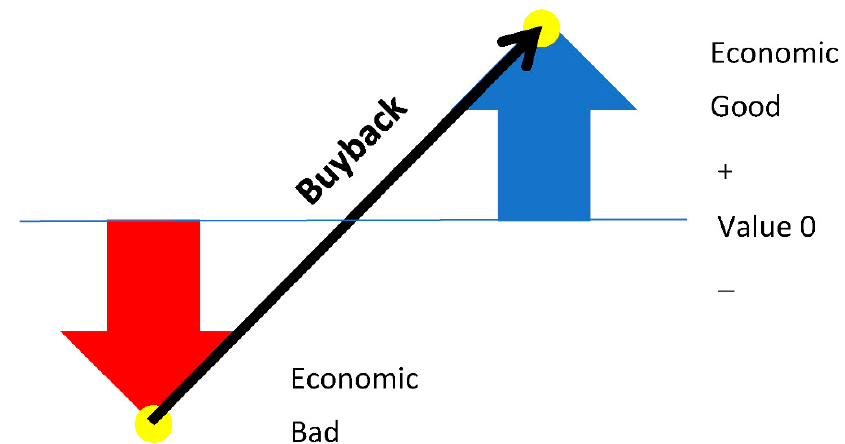
Figure 4. Buyback proposition can change the value of organic waste.